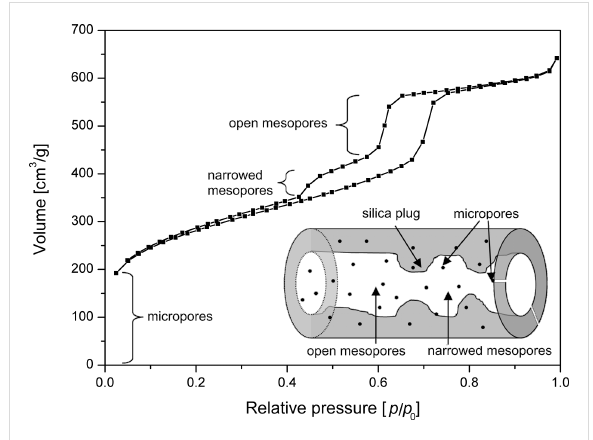
Figure 11: Effect of narrowed pores in the SBA-15 structure on the isotherm